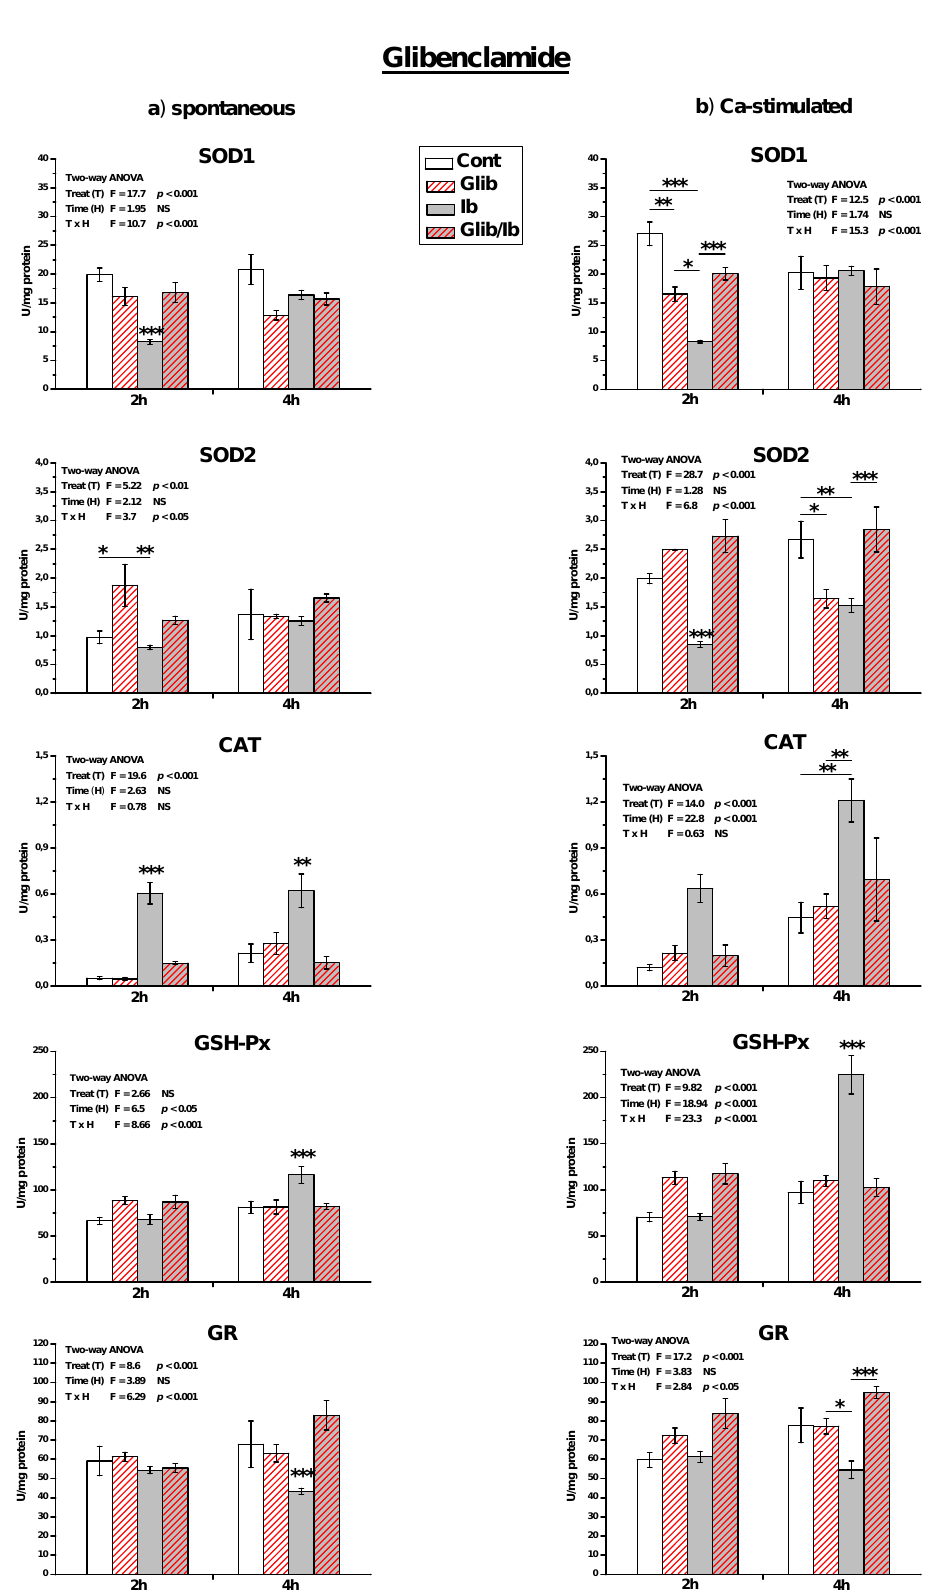
Figure 5. The activity of antioxidant enzymes in both spontaneous ( a ) and Ca 2+ -stimulated ( b ) active uteri treated with a single dose of ibogaine (28.8 µ mol/L) and pre-treated with glibenclamide. Data are expressed as the mean ± SEM ( n = 7). Statistical significance was tested by two-way ANOVA, and post hoc compared by Tukey’s HSD test. * p < 0.05; ** p < 0.01; *** p <